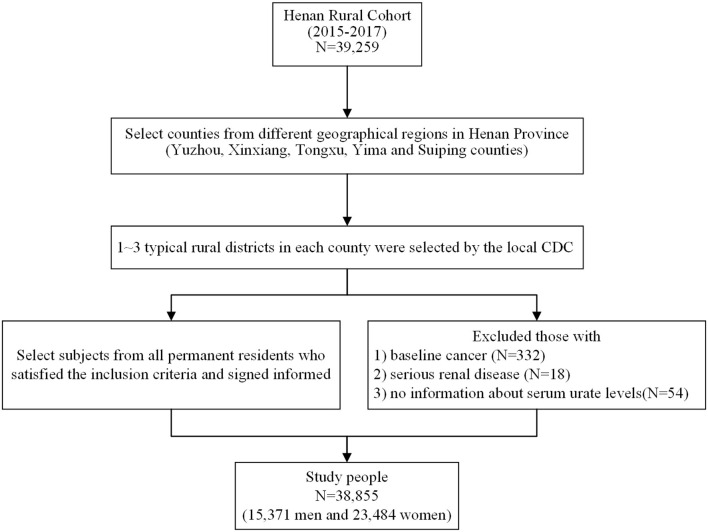
Flow chart showing inclusion of study participants from the initial cohort of 39,259 participants in the Henan Rural Cohort Study, 2015–2017.